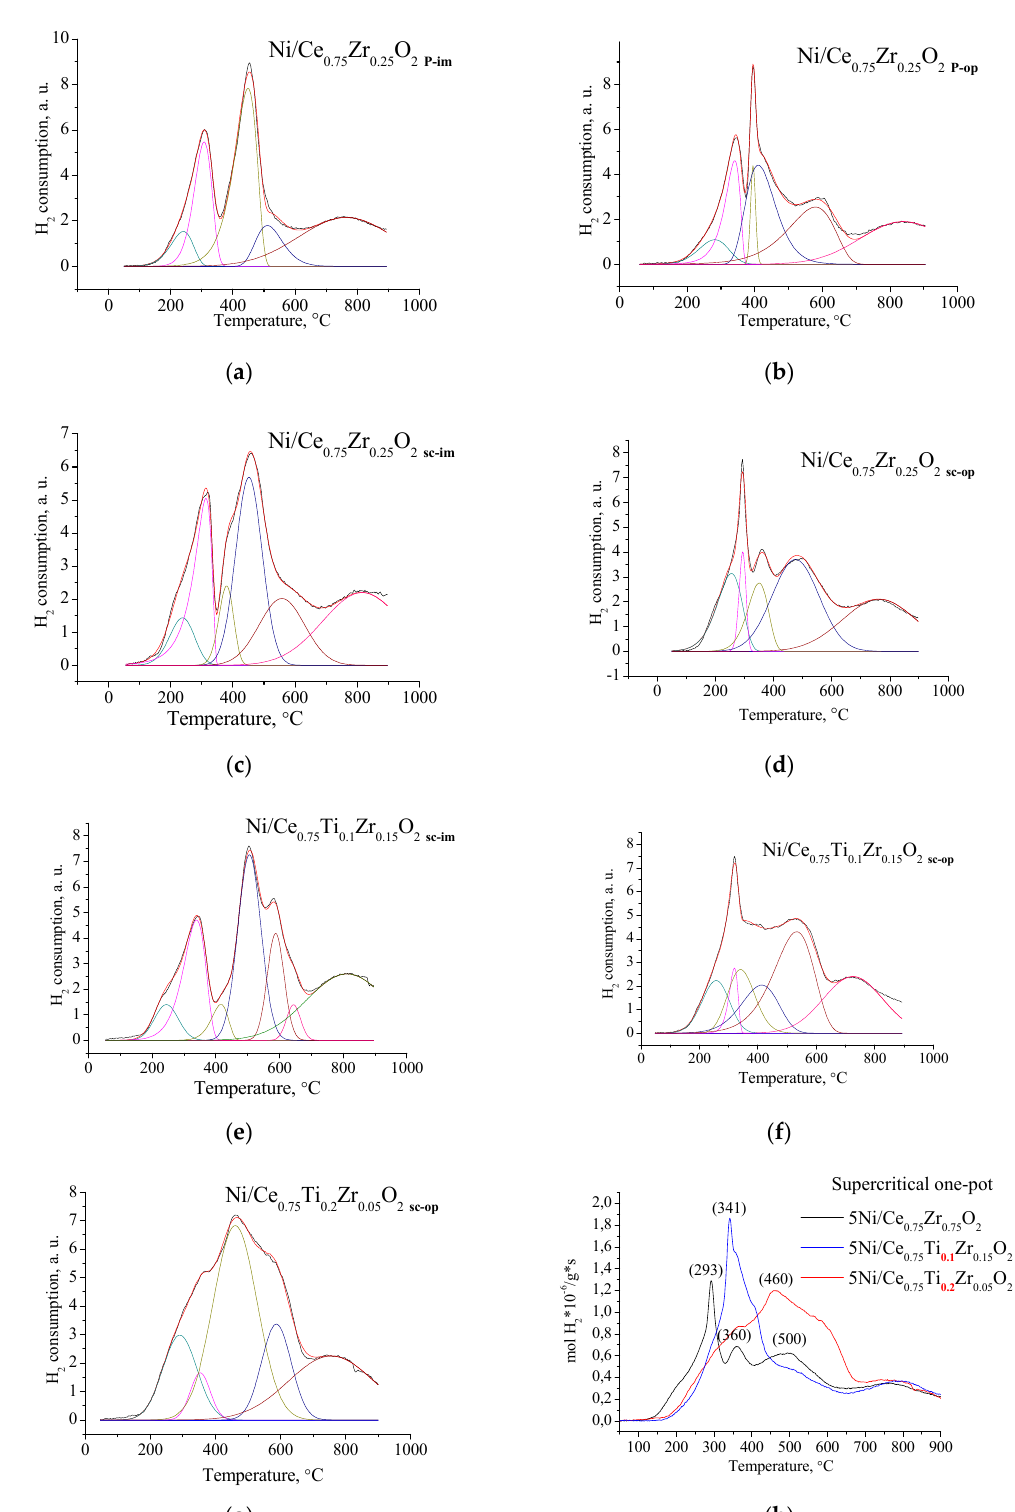
Figure 8. TPR-H 2 spectra of impregnated ( a ),( c ) and one-pot ( b ),( d ) 5%Ni/Ce 0.75 Zr 0.75 O 2- δ and impregnated ( e ) and one-pot ( f ), (g ) 5%Ni/Ce 0.75 Ti x Zr 0.25-x O 2- δ prepared using the Pechini route and in SC conditions; comparison of TPR-H 2 profiles of one-pot catalyst of different compositions prepared in supercritical alcohols ( h ).